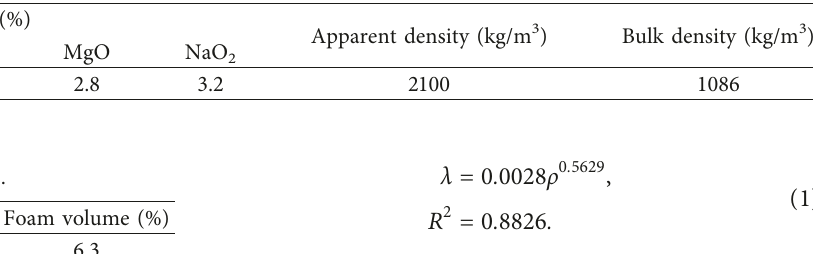
Table 2: Technical parameters of the fly ash.